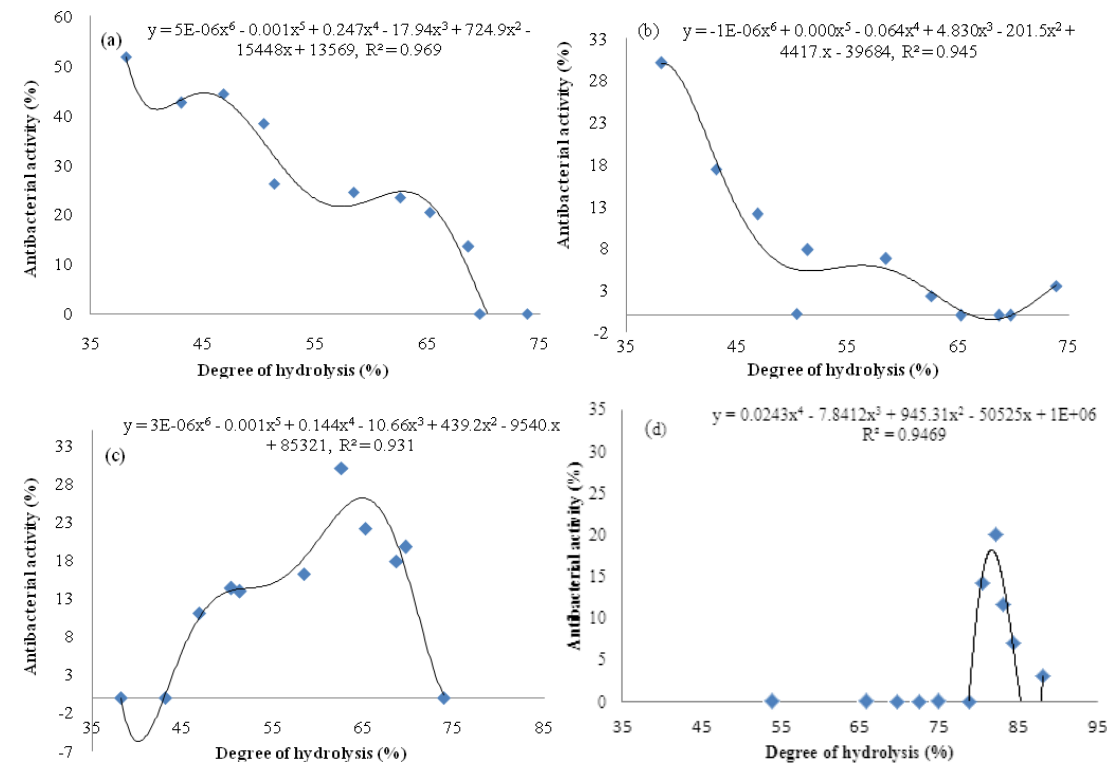
Figure 3. Relationship between DH and antibacterial activity of A. lecanora hydrolyzed by bromelain [( a ) and ( b )] and papain [( c ) and ( d )]: ( a ) Pseudomonas sp.; ( b ) P. aerogeniosa ; ( c ) E. coli ; and ( d ) S. aureus